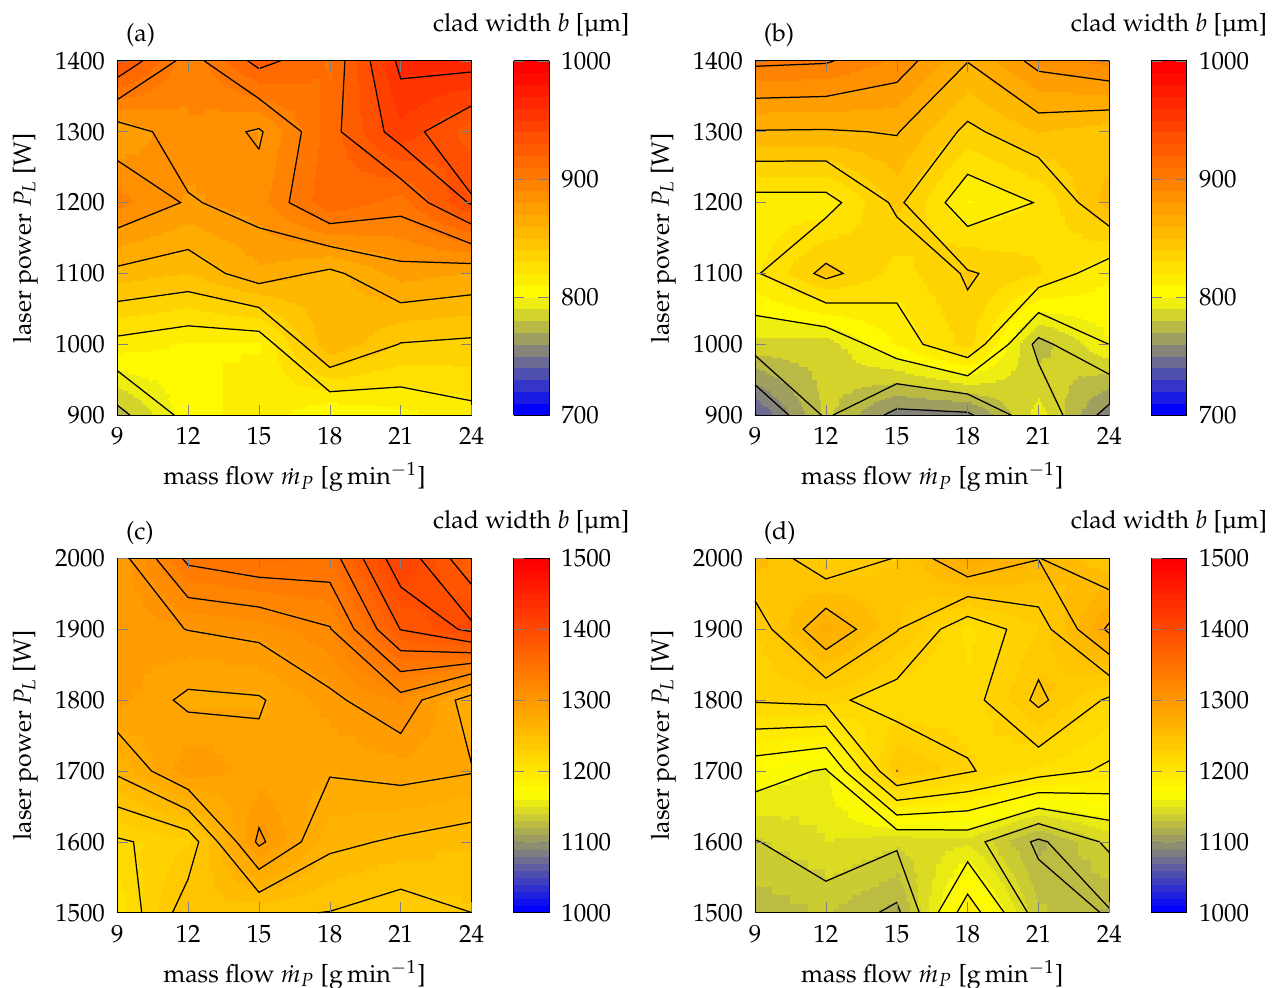
Figure 5. Development of clad width b in dependence on laser power P L and mass flow ˙ m P . Top: laser beam diameter 800µm, bottom: laser beam diameter d L d L ≈